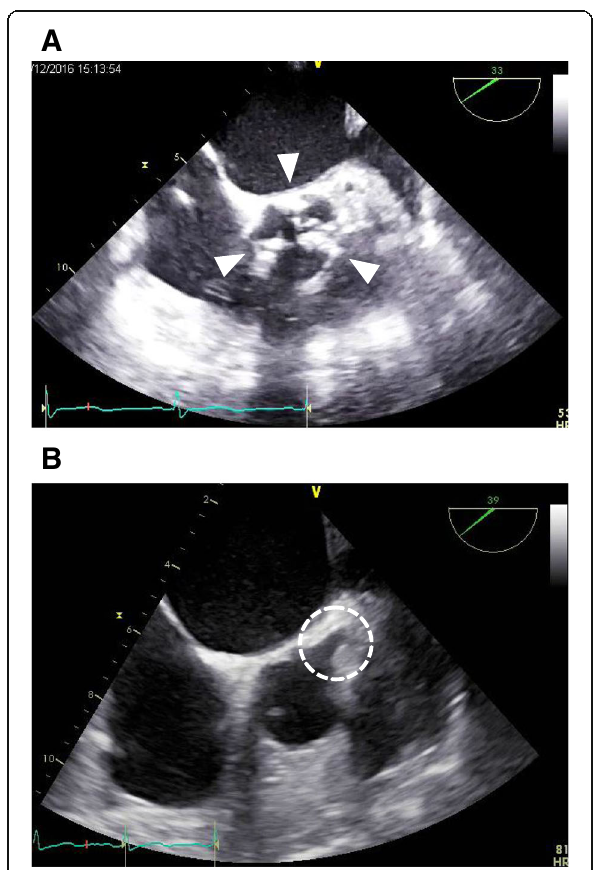
Fig. 1 a Preoperative transesophageal echocardiography. Severe calcification was observed in all leaflets and aortic annulus ( arrowheads ). b Preoperative transesophageal echocardiography. The left coronary ostium was intact; there was no significant stenosis